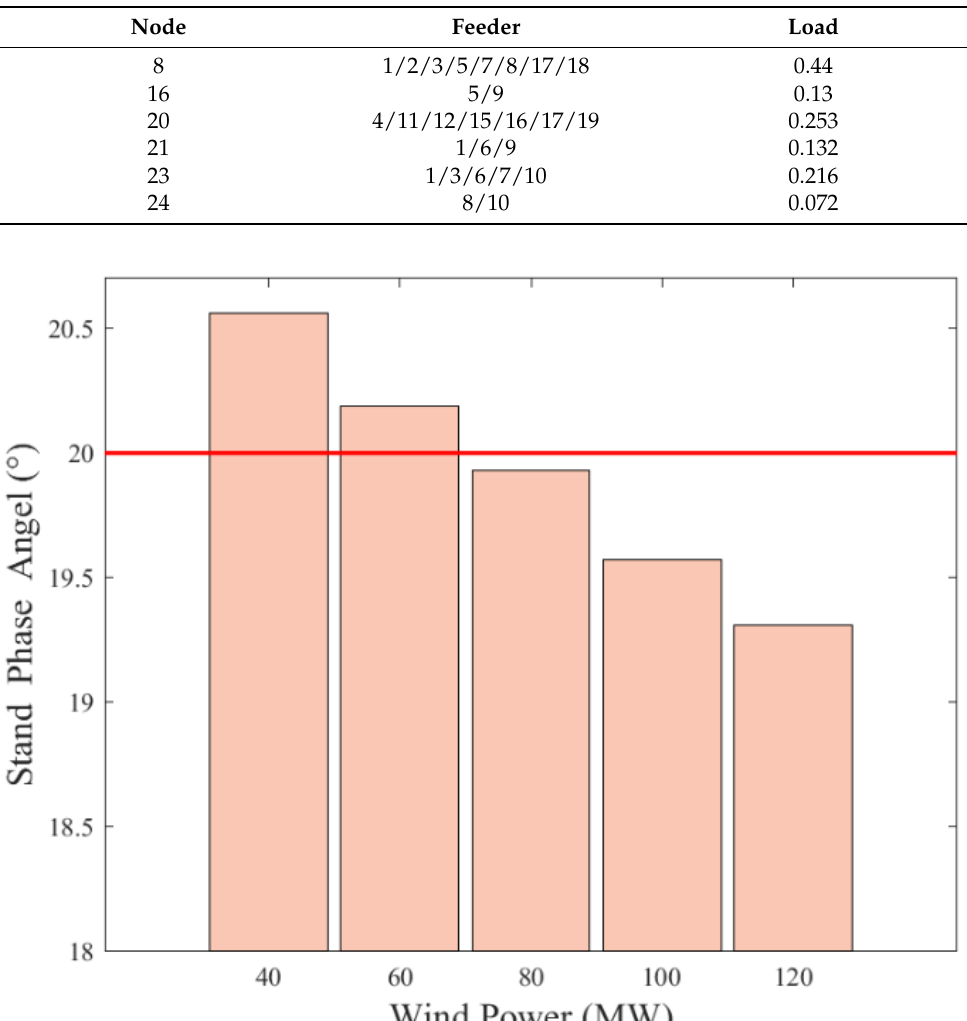
Table 10. Load recovery when the wind-power output is constant.